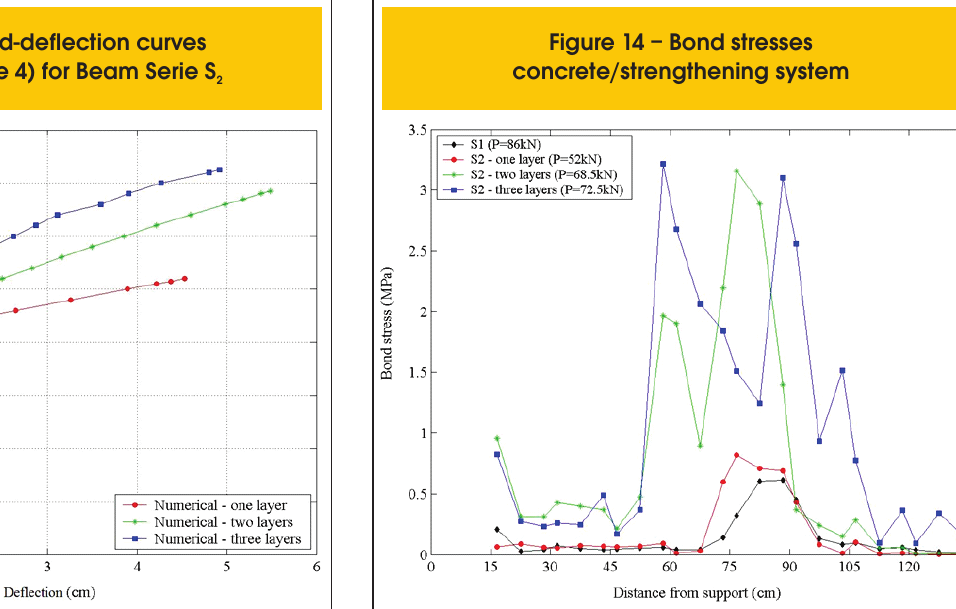
concrete/strengthening